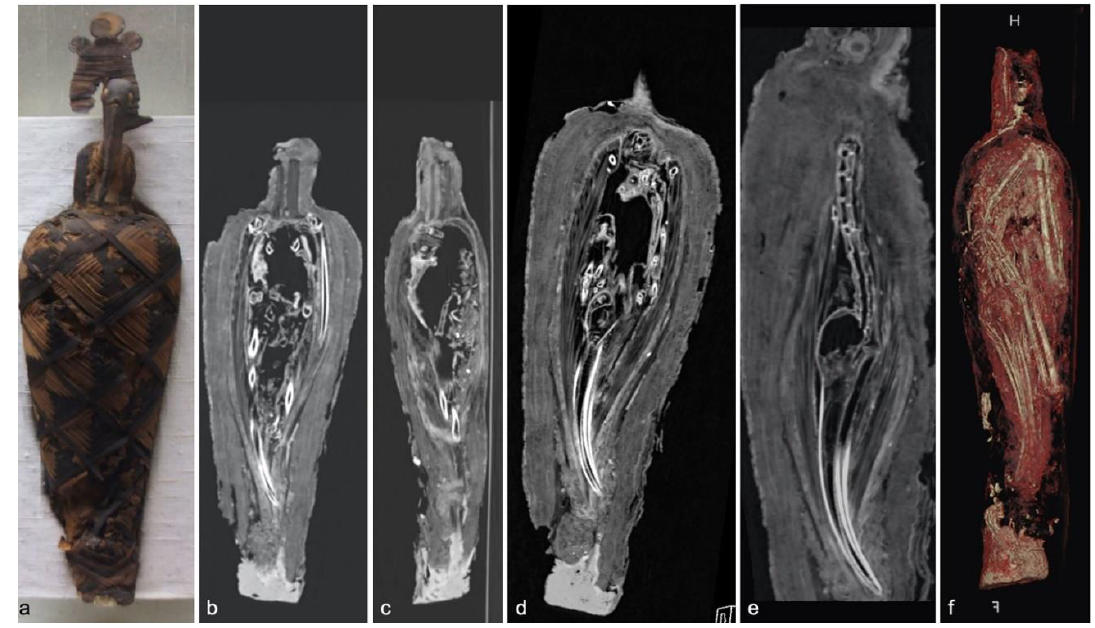
Figure 10. Figure showing Abydos mummy Manchester Museum acc. no. 6098. Images ( a ) photograph showing the addition of a removable false head depicting an ibis wearing the Atef crown, ( b ) coronal CT reformat ( c ) sagittal CT reformat ( d ) multiplanar reformat ( e ) multiplanar curved plane reformat ( f ) reformat showing the skeletal elements and preserved soft tissues. The radio-opacity at the distal end of the bundle is modern conservation wax added to consolidate the fragile bundle. [Photographs and radiographs created by author for the Ancient Egyptian Animal Bio